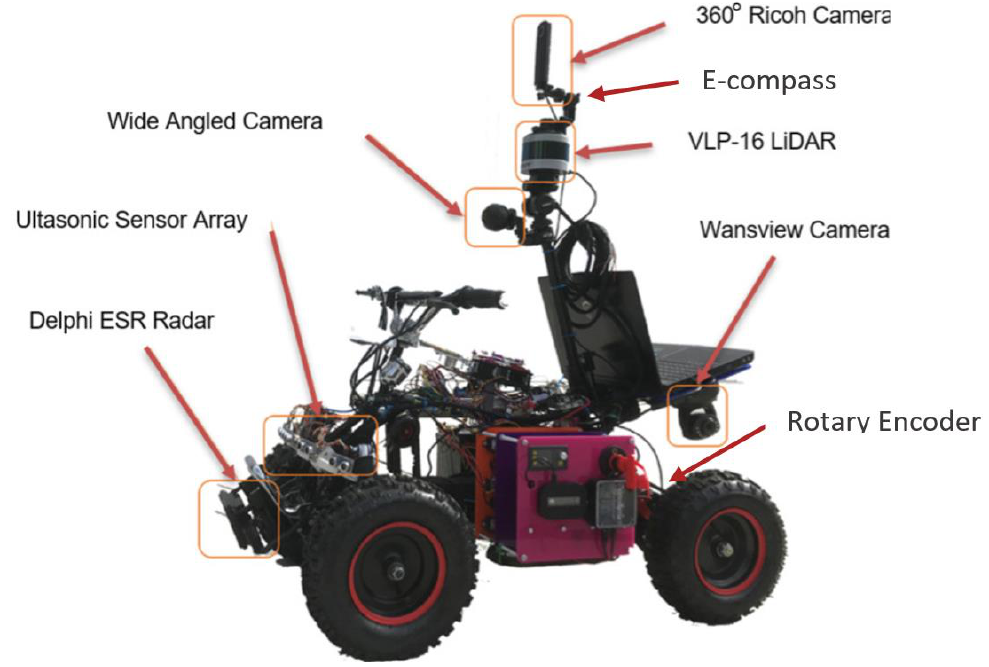
Figure 1. The unmanned ground vehicle used for LboroAV2 data collection [36].